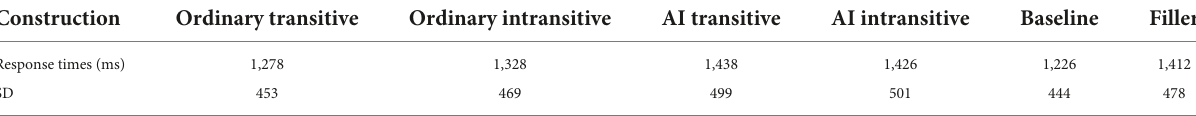
TABLE 5 Mean response times and standard deviations.